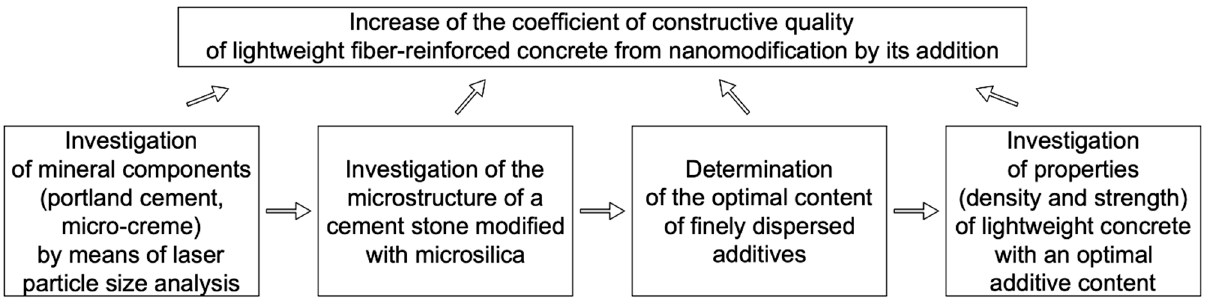
Figure 1. Structural and methodological scheme of experimental research.